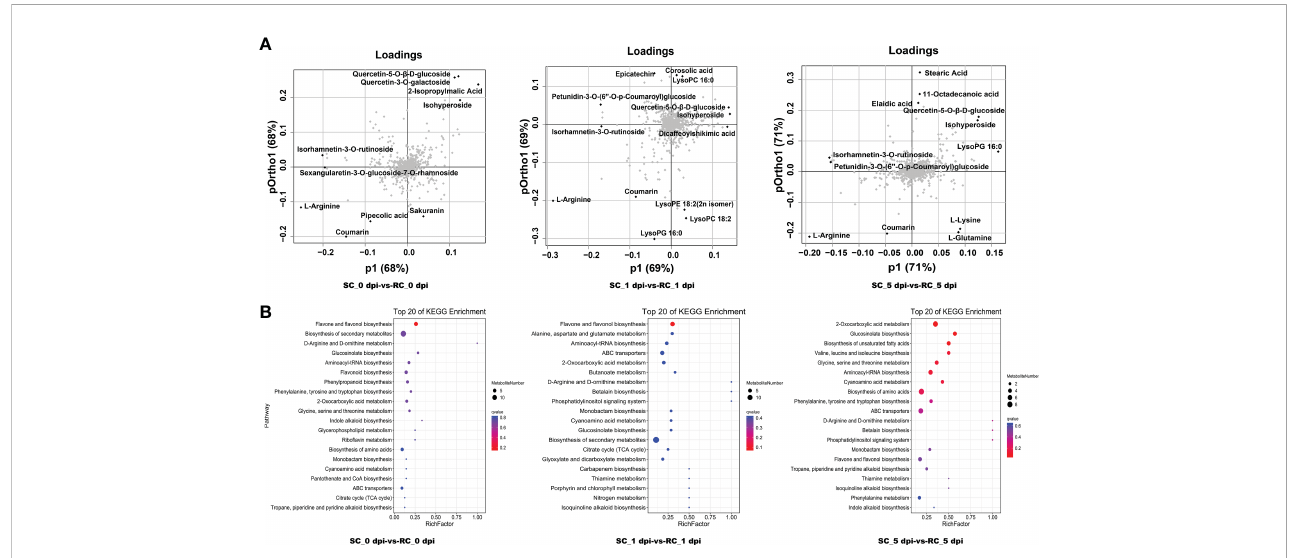
FIGURE 5 Analysis of differentially accumulated metabolites (DAMs) detected between the SC and RC. (A) Loading plots of DAMs. (B) KEGG pathway analysis of DAMs, the chart shows the top 20 pathways enriched in the selected